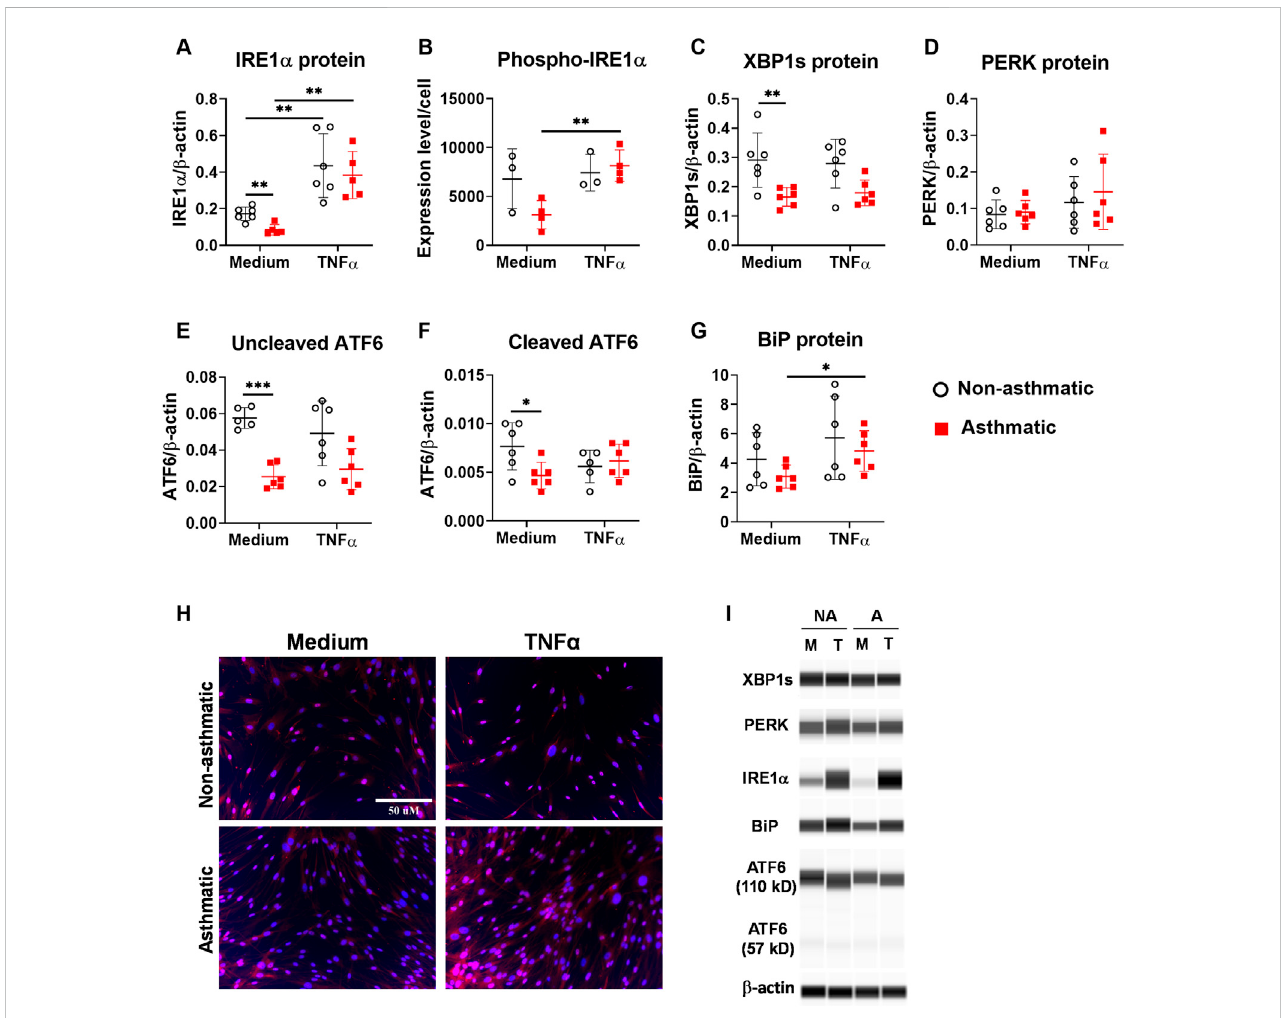
FIGURE 5 Protein expression of ER stress/UPR molecules in asthmatic and non-asthmatic human lung fi broblasts. Serum-starved fi broblasts were cultured with medium or TNF α (20 ng/ml) for 24 h. The protein expression in the cell lysates was determined by WES and normalized to the expression of β -actin (A, C – G) . Representative WES run images are shown in (I) (NA: non-asthmatic. A: asthmatic. M: medium. T: TNF α ). Normalized protein expression data are shown as mean ± SD from N = 5 – 6 patient samples (A, C – G) . Phospho-IRE1 α expression was quanti fi ed using images from immuno fl uorescence staining of fi broblasts and data are shown as mean ± SD from N = 3 – 4 patient samples (B) . Representative staining images are shown in (H) . Each dot represents one patient sample. * indicates signi fi cant difference p < 0.05. ** indicates signi fi cant difference p <